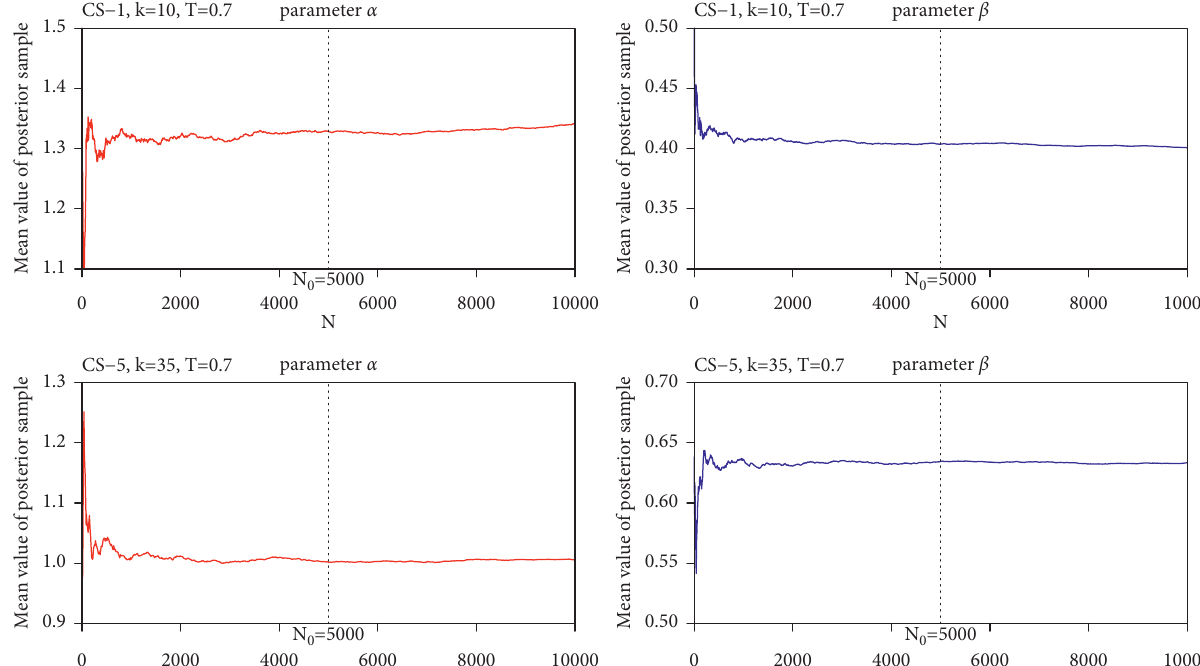
parameter α CS−2, k=13, T=0.9 parameter β CS−2, k=13, T=0.9